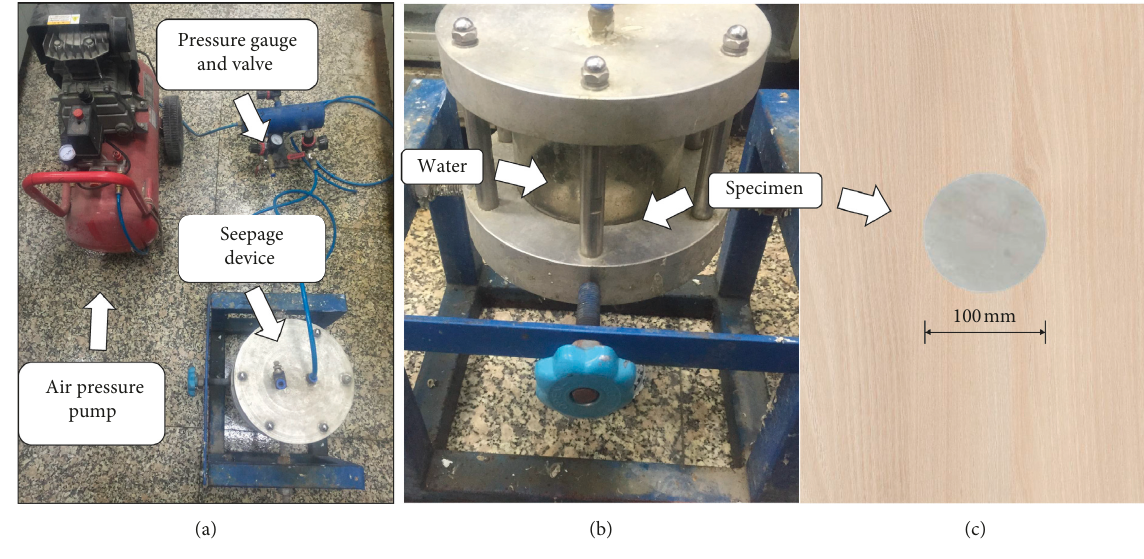
Figure 2: Permeability test: (a) test system; (b) seepage device; (c)